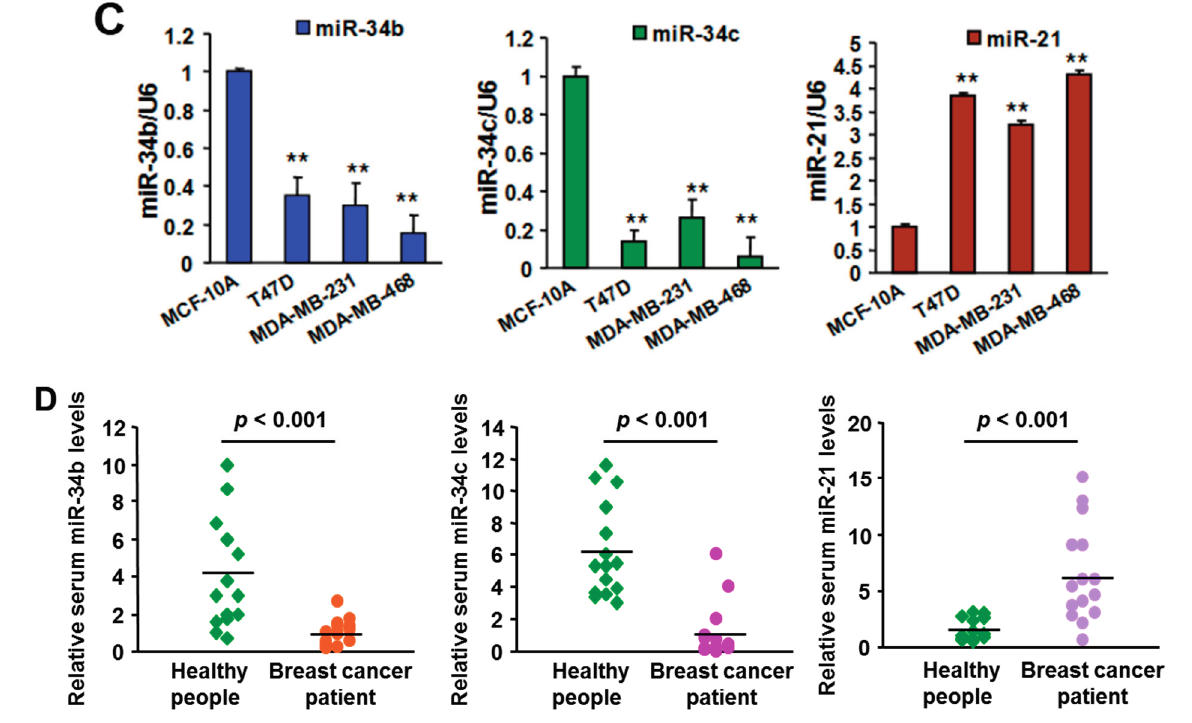
Figure 1. MiR-21 was upregulated and miR34b/c was down-regulated in breast cancer cells, tissues, and serums. ( A ) Relative expression levels of miR-21, miR-34b and miR-34c in 15 paired of breast cancer tumors (BCT) and non-malignant adjacent tissues (NT) were determined by RT-qPCR assay, and normalized to the U6 levels; ( B ) Scatter plots of the Spearman correlation coefficient (rho) corresponding to an inverted monotonic trend between relative miR-21, and miR-34b, or miR-34c levels in breast cancer tumors; ( C ) Levels of miR-21, miR-34b and miR-34 in MCF-10A, T47D, MDA-MB-231, and MDA-MB-468 cells were determined by RT-qPCR assay, and normalized to the U6 levels; and ( D ) Serum levels of miR-21, miR-34b and miR-34 in breast cancer patients and healthy people were analyzed by Taqman RT-qPCR assay. All results represent the mean ± SD from three independent experiments. ** indicate significant difference at p < 0.01,